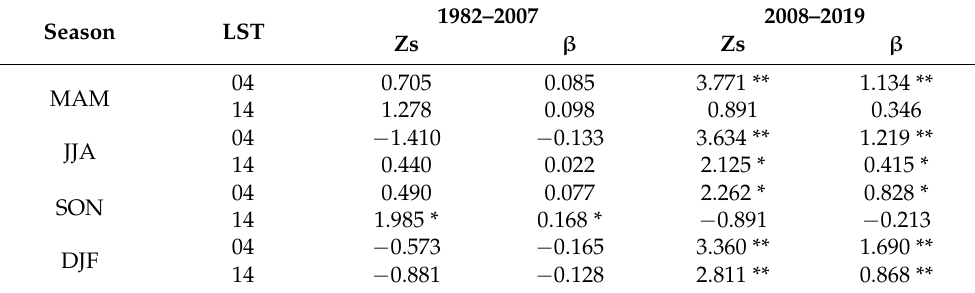
Table 2. Results derived by the Mann–Kendall and Sen’s slope statistical tests for seasonal CF for periods of 1982–2007 and 2008–2019.